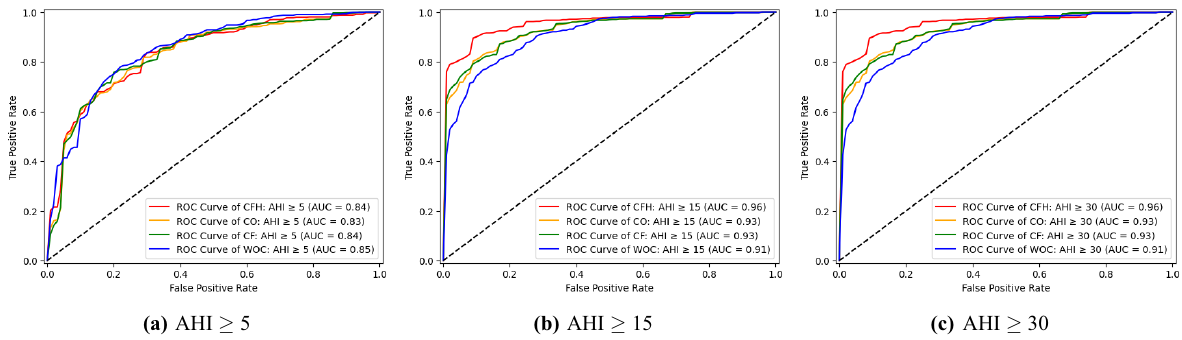
Figure 6. Comparisons of receiver operation characteristic(ROC) curves based on approach to building predictive models. Best records were used for plotting. WOC: Without clustering, CO: Clustering only, CF: Clustering with feature engineering, CFH: Clustering with feature engineering and hyper-parameter